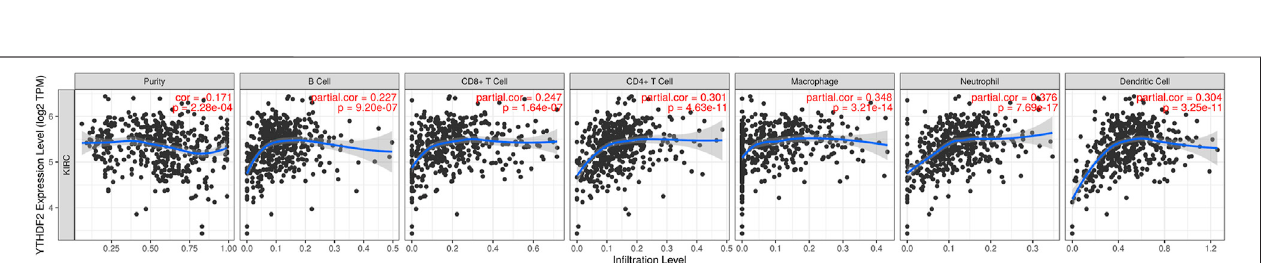
Frontiers in Pharmacology |